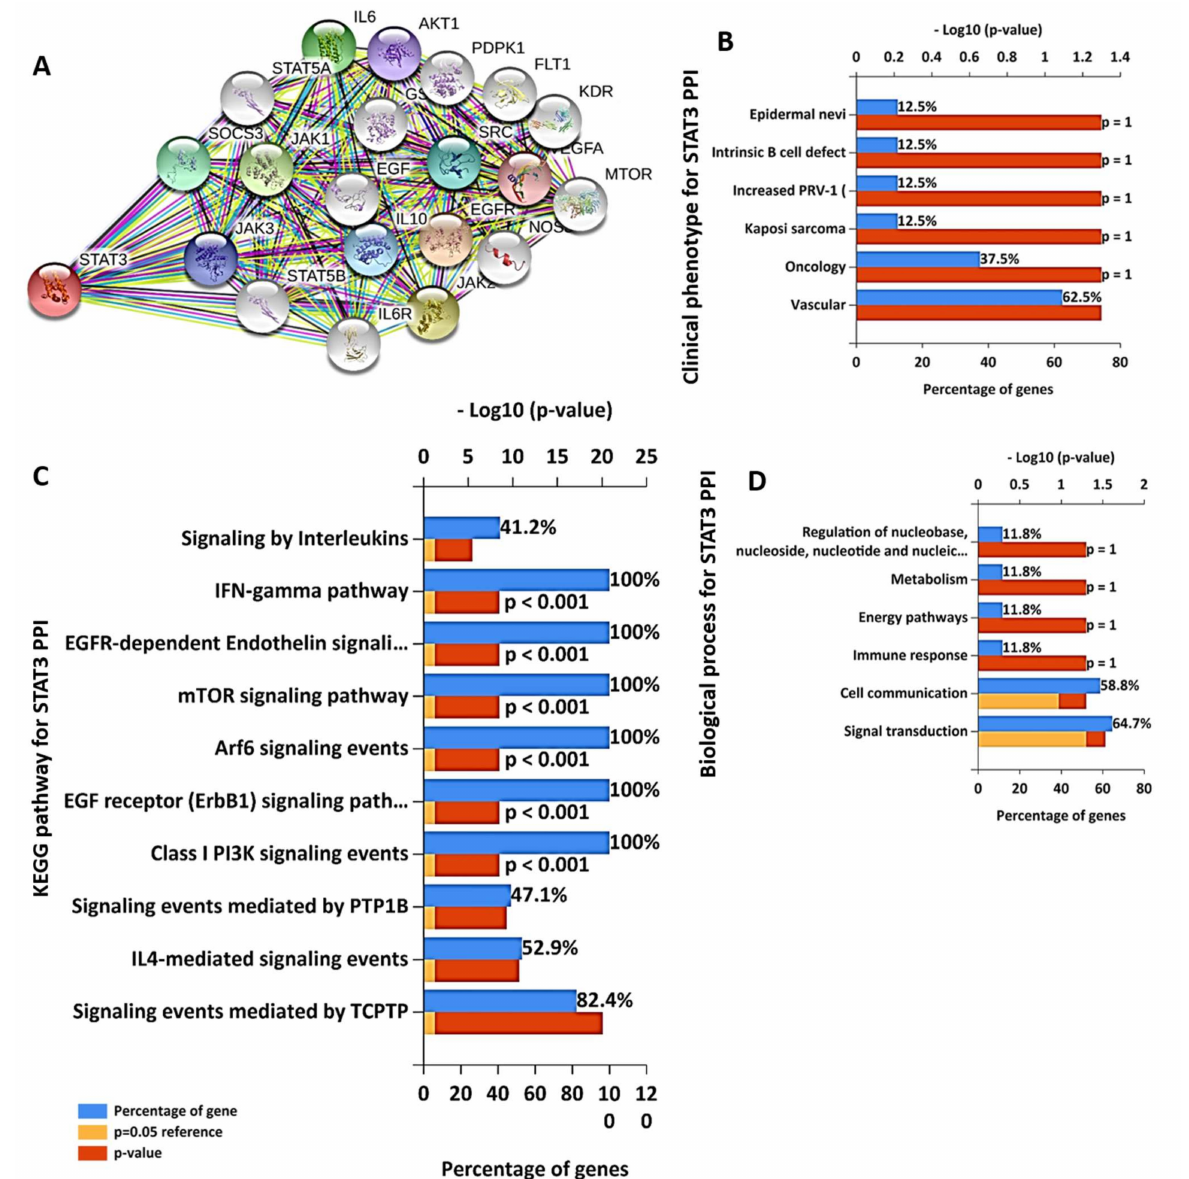
Figure 5. STAT3 clustering network revealed multiple interactions with oncogenic proteins. ( A ) Clustering network of STAT3-associated protein interactions. STAT3-associated protein interactions generated a total of 21 nodes and 161 edges with an average local clustering coefficient of 0.873 and protein-protein interaction (PPI) enrichment p -value of <10 − 16 . Interactions are depicted at the highest confidence limit (0.900). Enriched ( B ) clinical phenotypes, ( C ) KEGG pathways, and ( D ) biological processes for STAT3 clustering